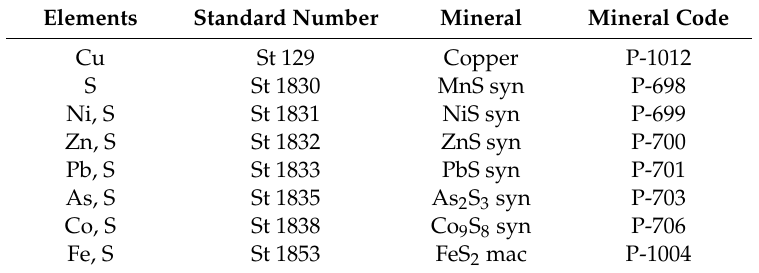
Table 2. Details of the standards used during electron probe microanalaysis (EPMA)